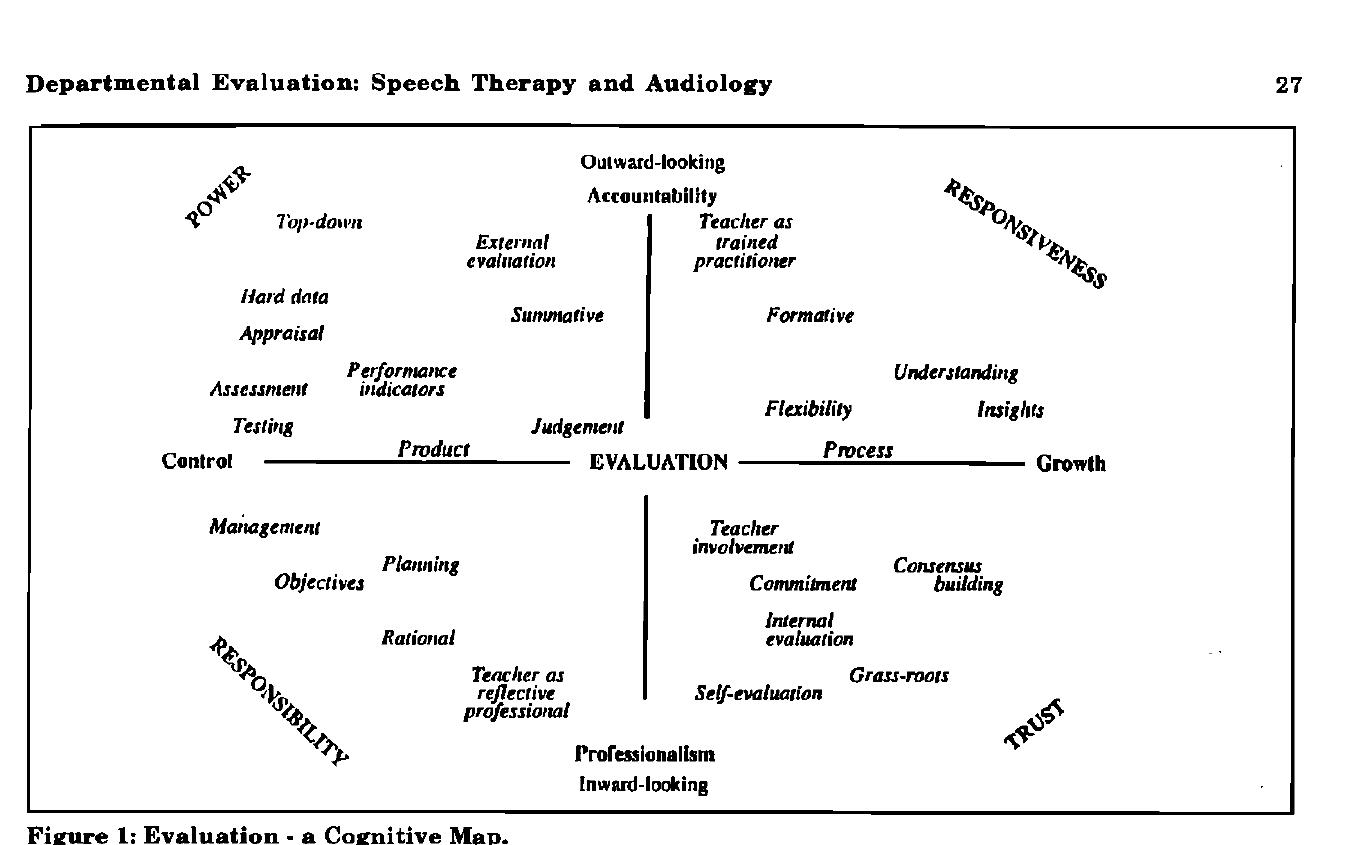
Figure 1: Evaluation - a Cognitive